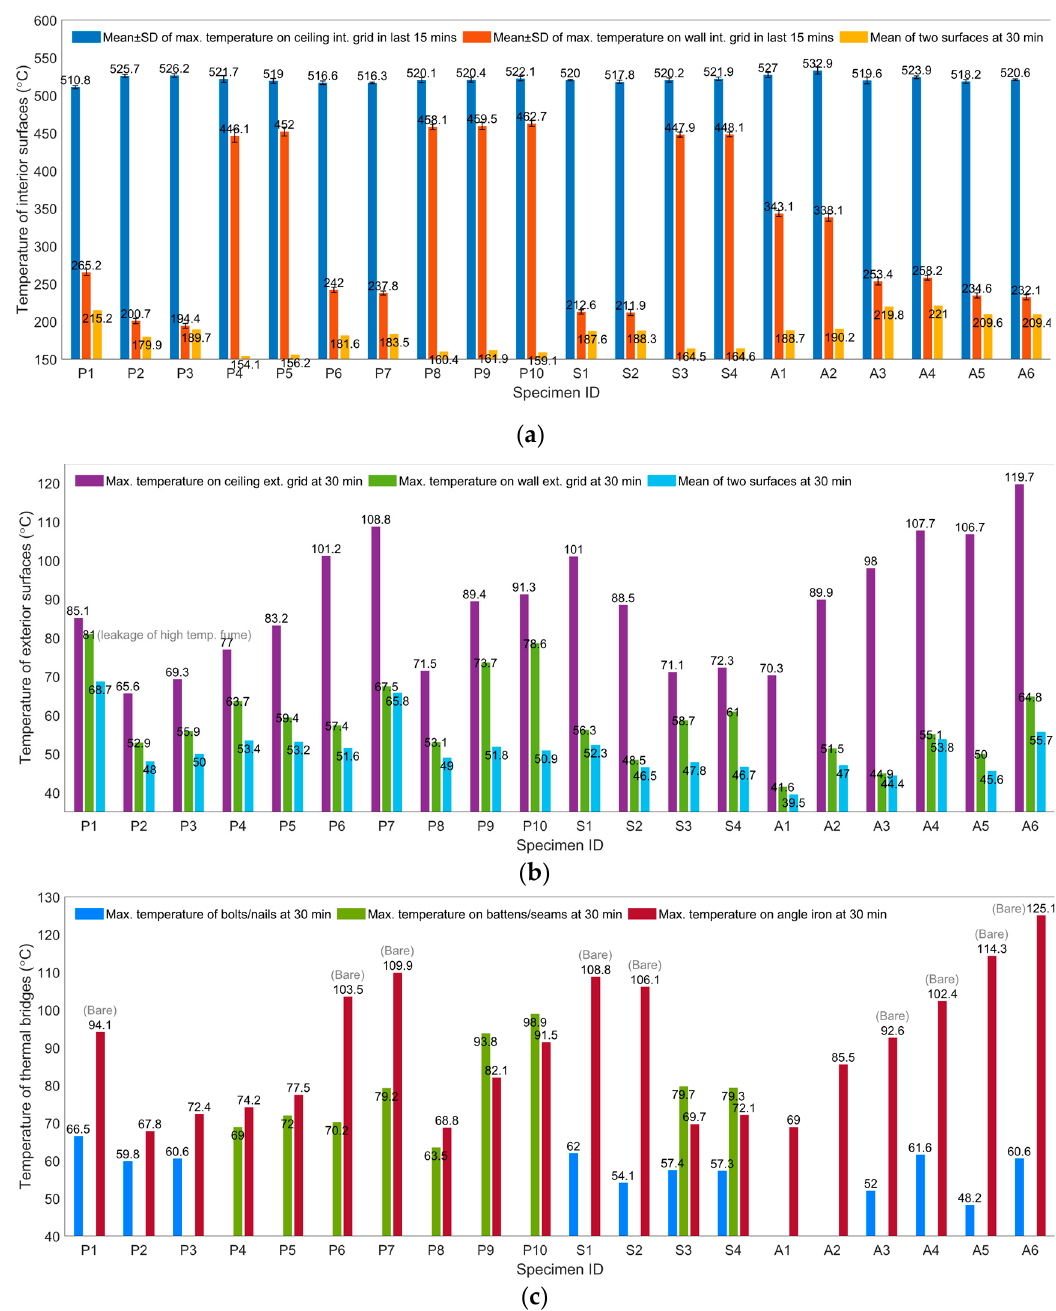
Figure 9. Cross-specimen comparisons: ( a ) grid temperature on two interior surfaces; ( b ) grid temperature on two exterior surfaces; and ( c ) thermal bridge effects of various fabrication methods.